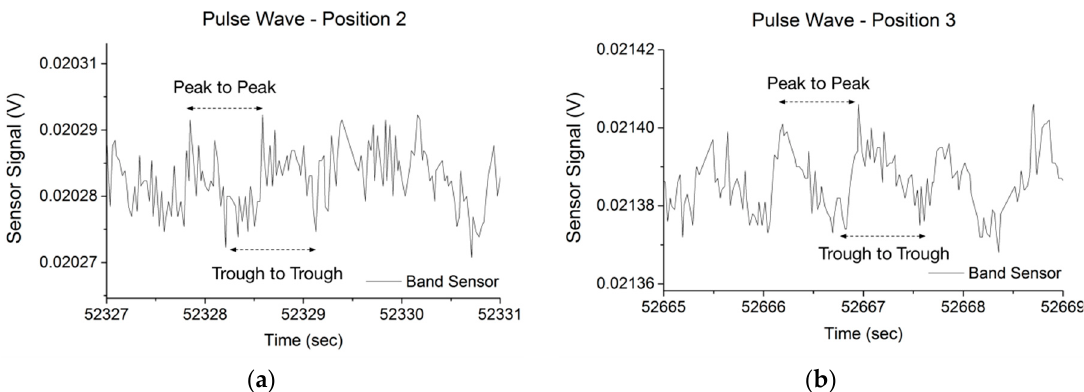
Figure 16. Band sensor pulse wave results for Position 2 ( a ) and Position 3 ( b ).